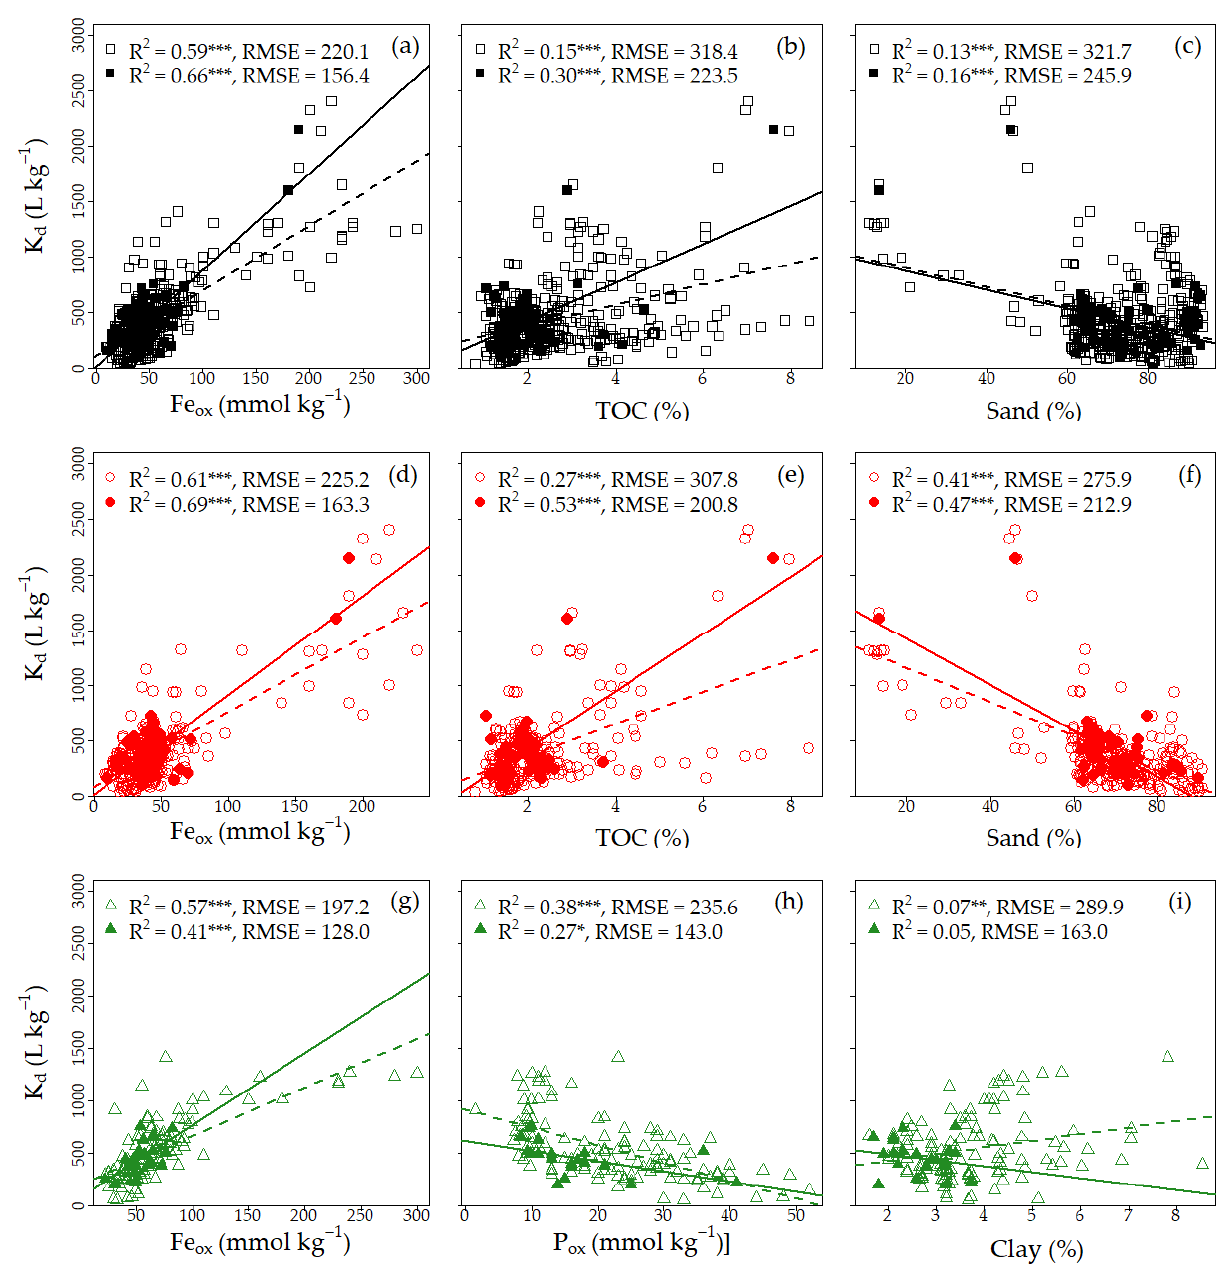
Figure 4. The best three single linear regression models to predict the K d of glyphosate for the combined ( a – c ), Danish ( d – f ), and Greenlandic ( g – i ) datasets. TOC, total organic carbon; K d , soil sorption coe ffi cient of glyphosate; Fe ox and P ox , oxalate-extractable iron and phosphorous; R 2 , coe ffi cient of determination at signi fi cance levels of * 0.05, ** 0.01 and *** 0.001; RMSE, root mean square error; Symbology, open symbol represents samples from the calibration subset and closed symbol represents samples from the validation subset for all datasets; Regression line, dashed line for the calibration subset and solid line for the validation subset of each dataset.